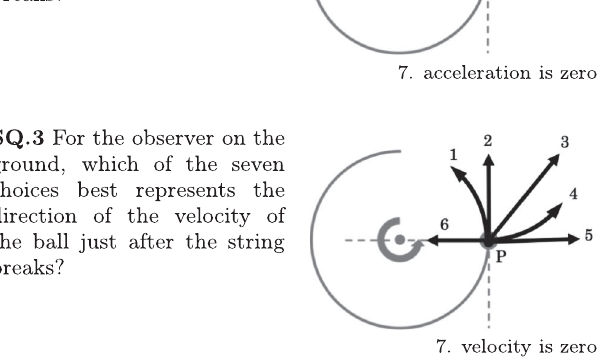
FIG. 4 (color online). Subquestions of FCI